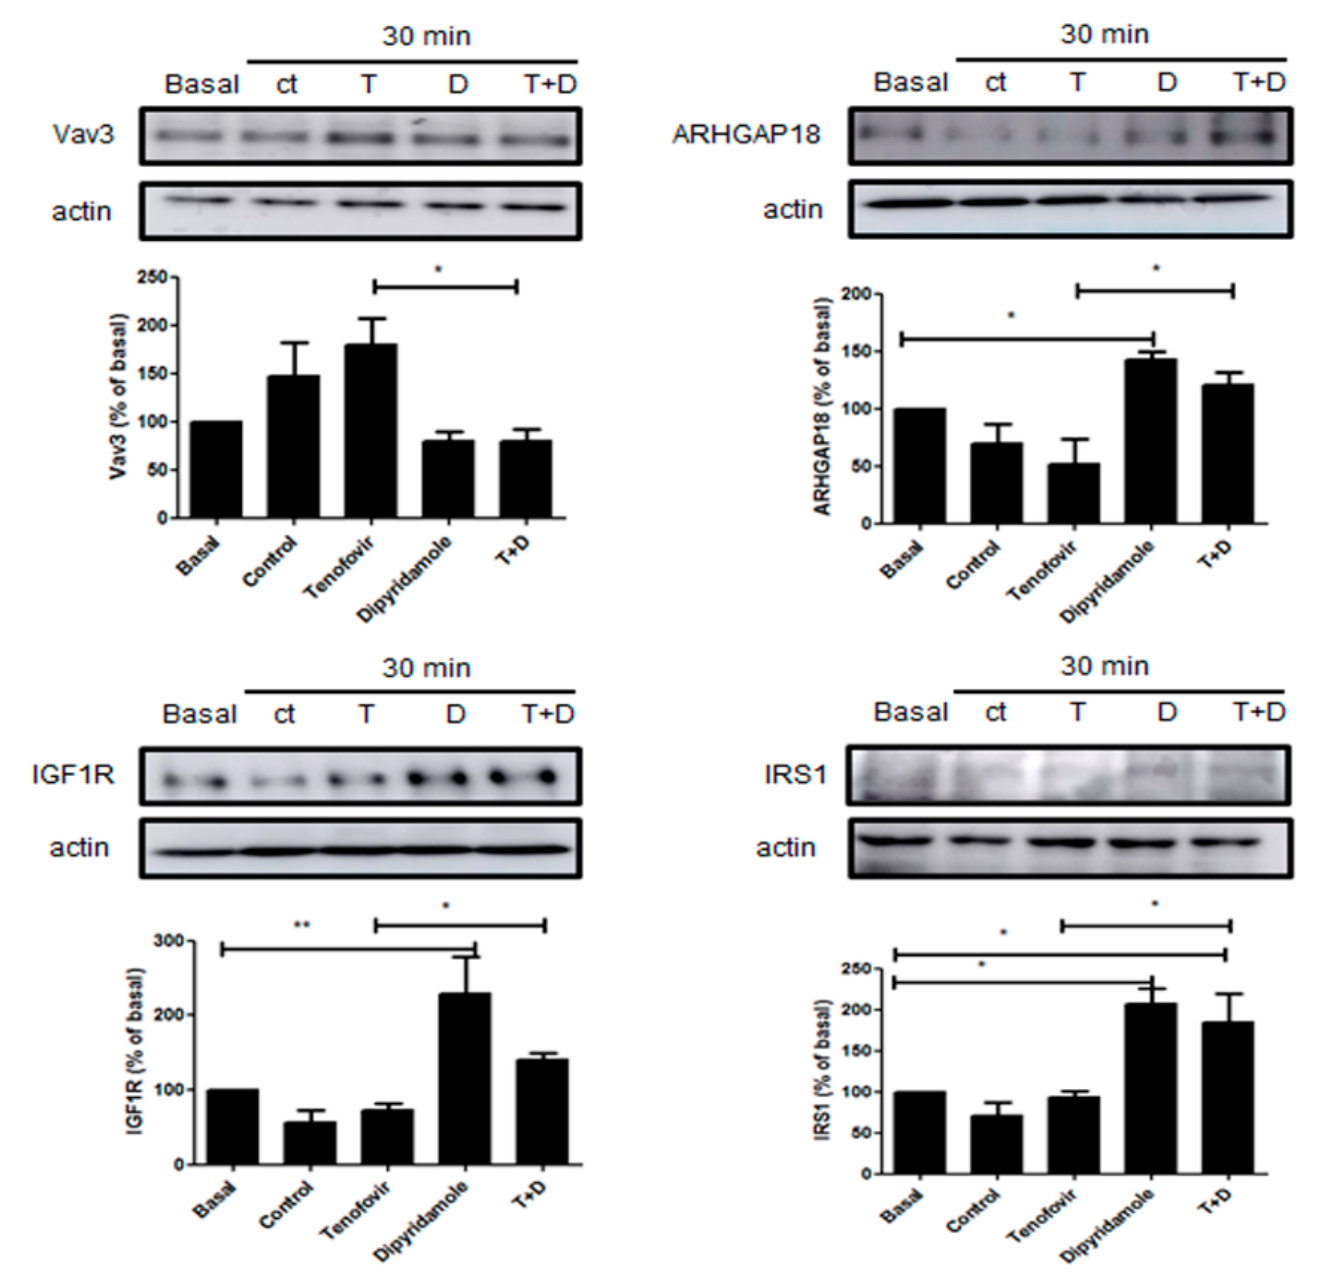
Figure 6. Tenofovir at 1 µ M inhibited IGF1R activation via activation of the GEF protein Vav3 in WT mice.Vav3, ARHGAP18, IGF1R and IRS1 expression were studied in osteoblast precursors in the presence of tenofovir at 1 µ M alone or with dipyridamole at 1 µ M. To normalize for protein loading, the membranes were reprobed with actin. * p < 0.05 ** p < 0.005 ANOVA.